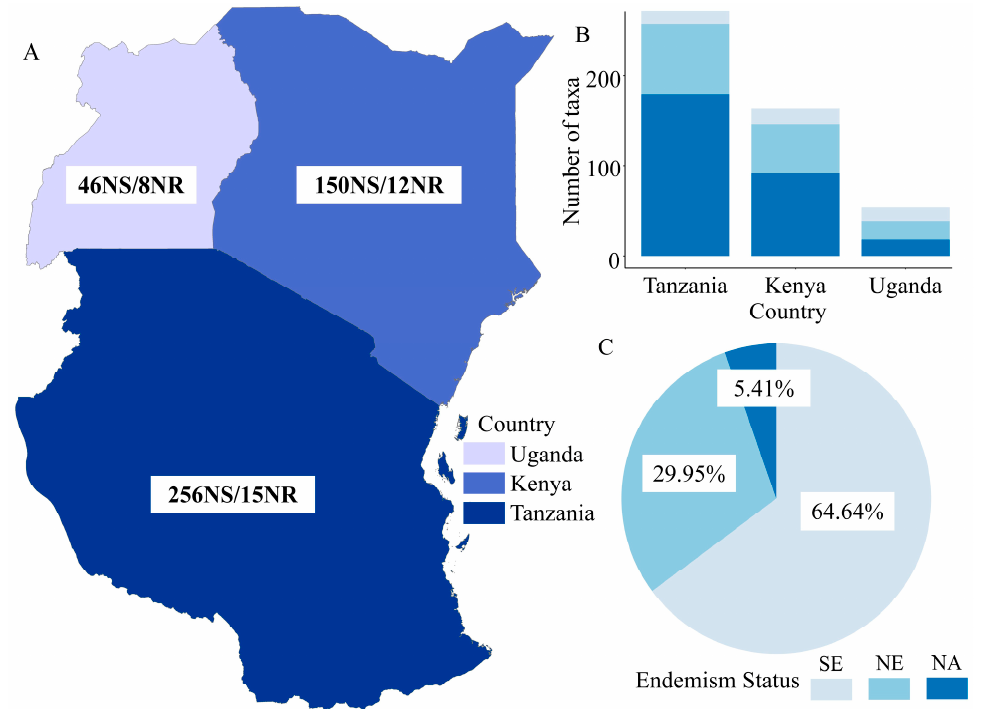
Figure 1. Overview of new and newly recorded taxa and endemism of plants in tropical East Africa countries. ( A ) Number of new and newly recorded taxa in each country; ( B ) Number of new endemic taxa in each country; ( C ) Proportions of different endemism in TEA. NS: new species; NR: new records; SE: strictly endemic; NE: near-endemic; NA: non-endemic.